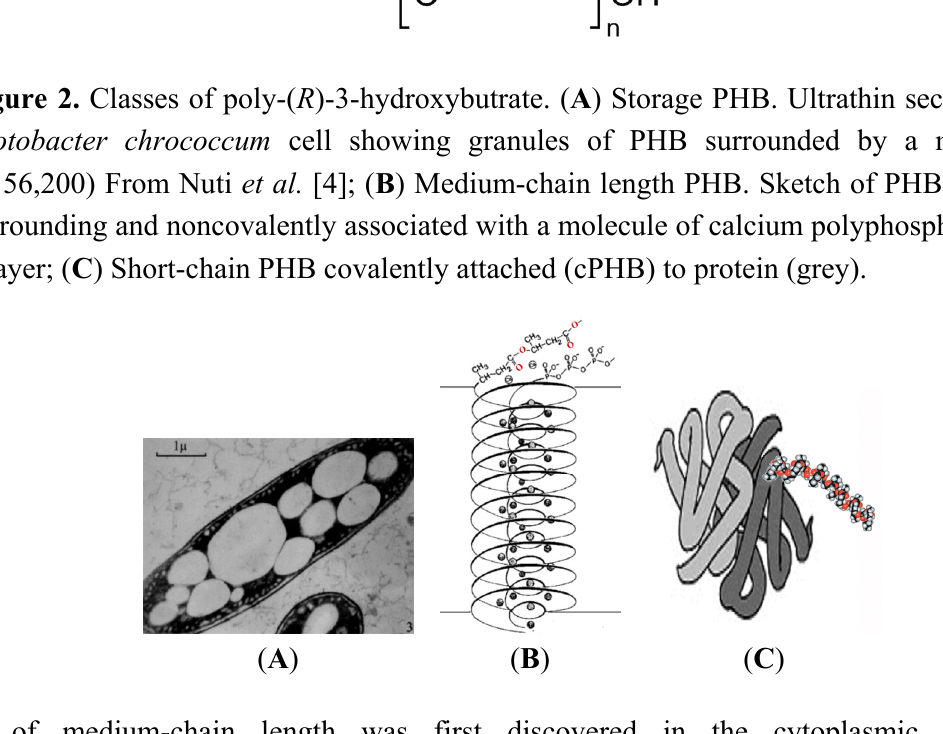
Figure 2. Classes of poly-( R )-3-hydroxybutrate. ( A ) Storage PHB. Ultrathin section of